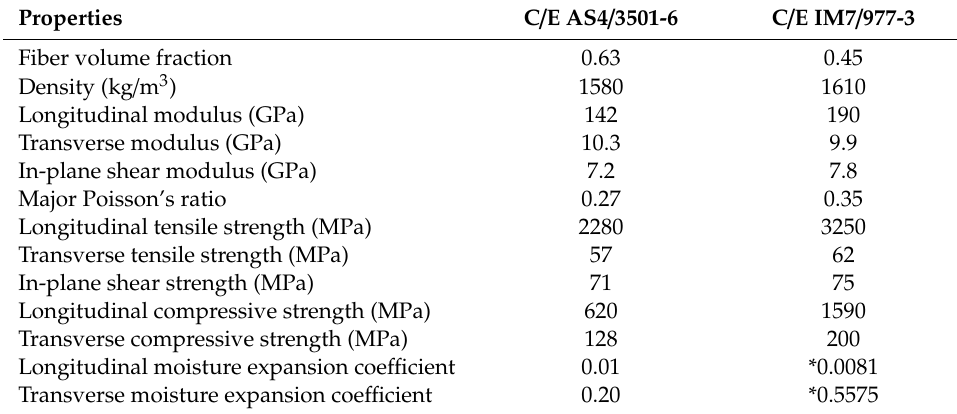
Figure 2. Thin-walled PV made of composite material. Table 3. Properties of the composite materials used in this work, from [15]. Properties indicated by (*) are found using composite micromechanics relations from [14]. C/E: carbon/epoxy.